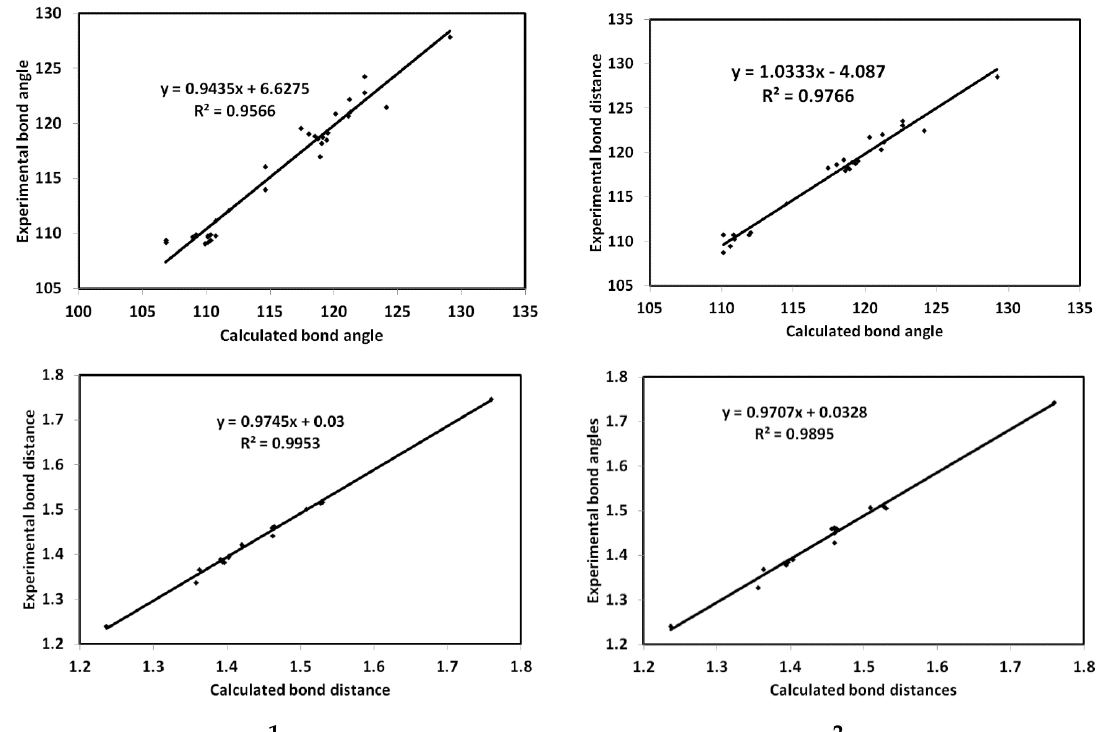
Figure 8. Optimized geometry (upper), and optimized/calculated structures overlay (lower) for compounds 1 , and 2 .